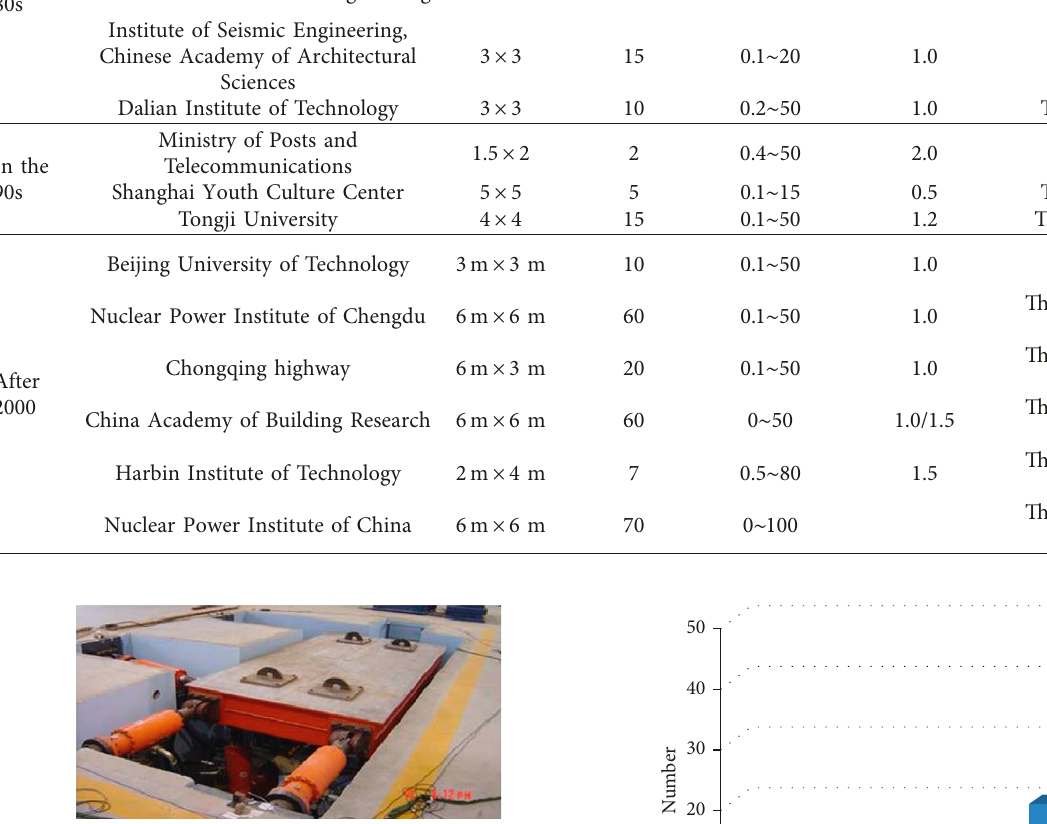
Figure 1: Six-DOF electrohydraulic vibration table produced by IEST.